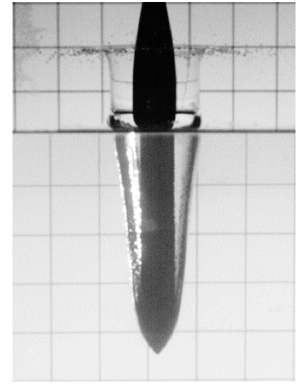
Figure 23. Cavity wall